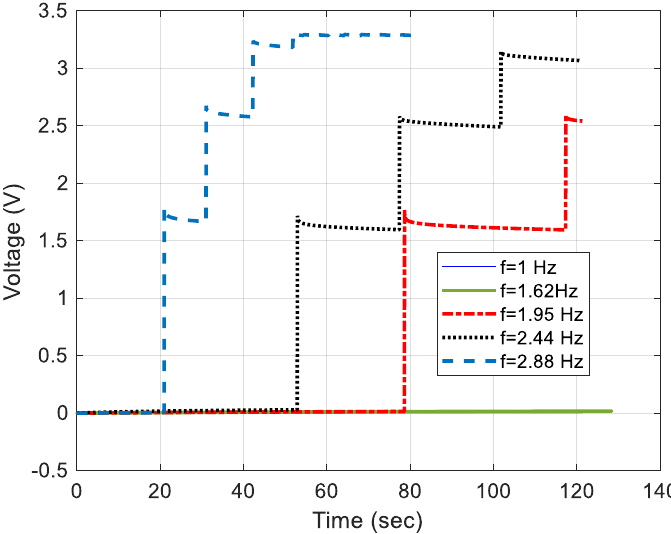
Figure 8. Frequency effect on the open circuit output voltage of LTC3588; C in = 22 μ F, C out = 47 μ F.